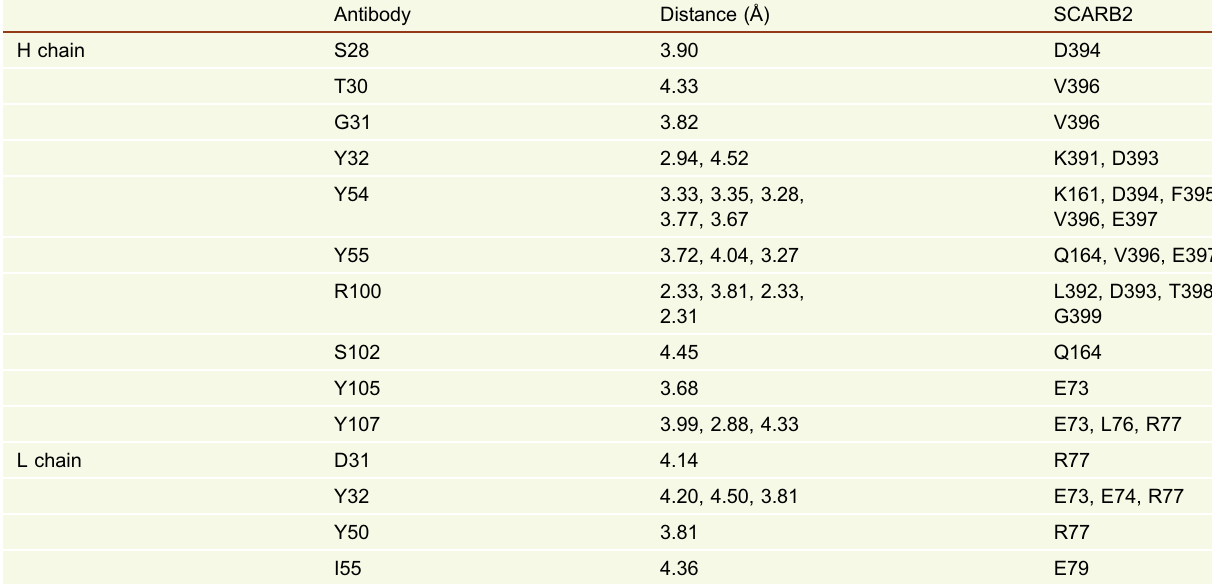
Figure 5. The analysis of the detailed interactions between the JL2 Fab and SCARB2. (A) Five polypeptide elements, three from the heavy chain (purple) and two from the light chain (marine), surround the domain III of SCARB2. Ten residues, S28, T30, G31, Y32, Y54, Y55, R100, S102, Y105, and Y107, in the heavy chain and four residues, D31, Y32, Y50, and I55, in the light chain interact with SCARB2 (with distance less than 4.5 Å). The residues in JL2 Fab involved in the interactions with SCARB2 are shown as sticks. (B) Similar to (A), a semi-transparent surface rendering of SCARB2 presents the detailed interactions. All residues involved in the interactions are shown as sticks. Table 2. Interaction residues between JL2 Fab and SCARB2